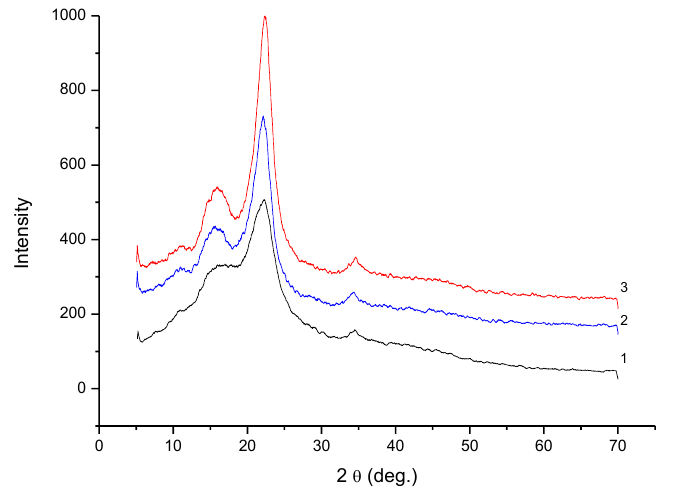
Figure 15. X-ray diffraction patterns for the initial spruce wood sample (1) and solid products of RCF over the 3RS400 (2) and 3RS450 (3) catalysts.